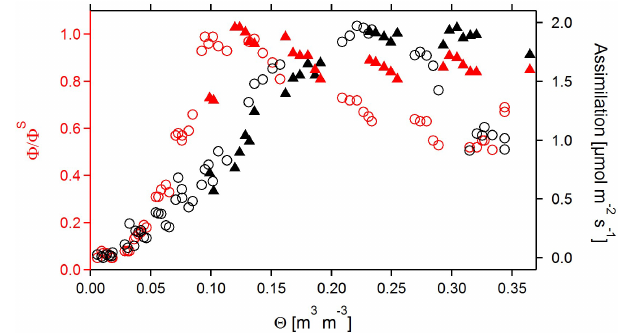
Figure 4. Normalized sabinene emissions from beech (red sym- bols, left scale) and rates of net photosynthesis (black symbols, right scale, multiplied by − 1) in dependence on (cid:50) . Closed triangles represent data taken during a first drought period that was stopped when (cid:50) had fallen to 0.1m 3 × m − 3 (days 0–5 in Fig. 3), open cir- cles represent data taken during the following period of recovery (days 6–10 in Fig. 3) until the end of the severe drought at day 17. Only data taken at a chamber temperature of 23 ◦ C and a PAR of 440µmolm − 2 s − 1 are considered.